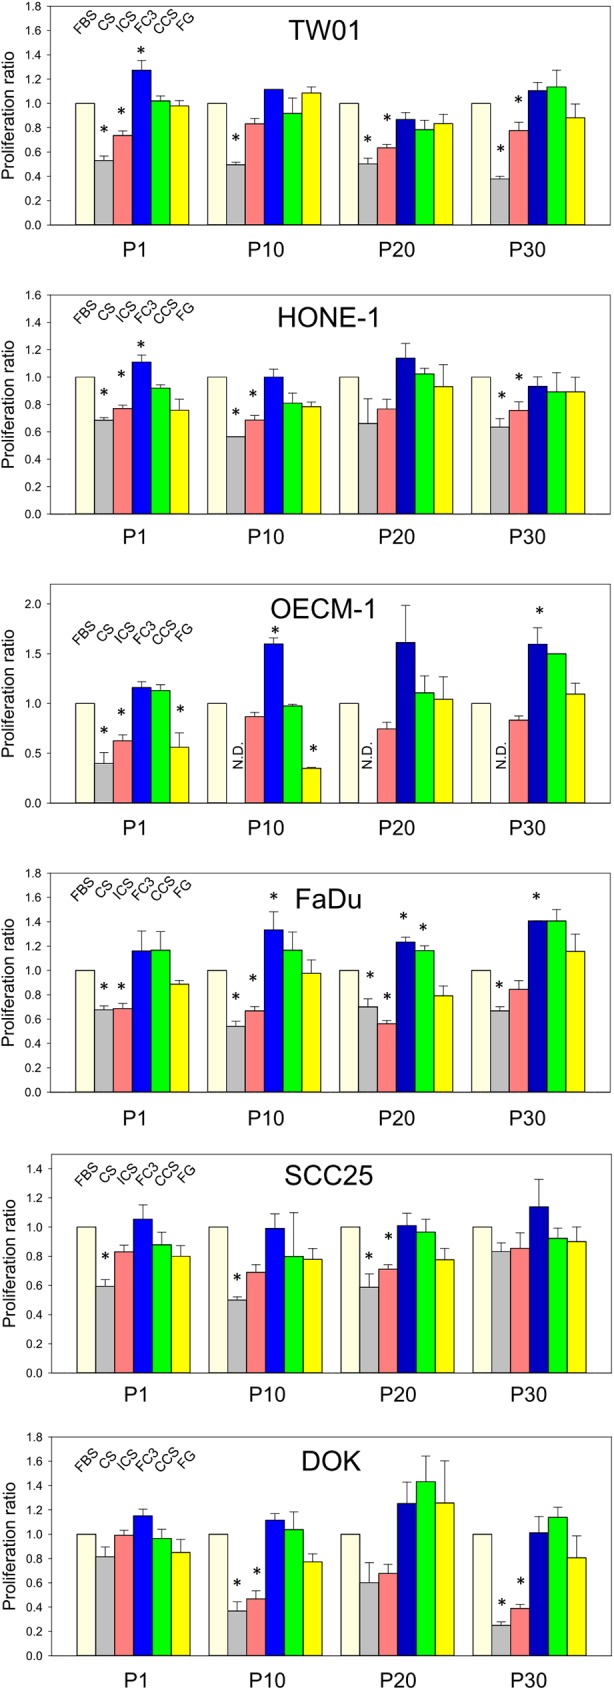
Long-term proliferation comparison of cells in FBS and alternative sera.The proliferation profiles of cells cultured in fetal bovine serum (FBS), calf serum (CS), iron-supplemented calf serum (ICS), FetalClone III (FC3), Cosmic calf serum (CCS), and Fetalgro (FG) were presented at passages 1, 10, 20, and 30. Cells cultured in FBS were adjusted as the baseline (1.0-fold), and the relative proliferation ratio of cells in other sera was determined accordingly. Data indicate the average value of triplicates (mean ± SD). *:p<0.01 compared with cells cultured in FBS at the same passage. N.D.: not determined for OECM-1 cells cultured in CS due to subculture termination at passage 10.